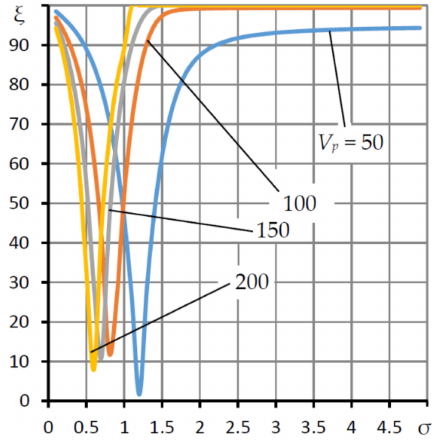
Figure 10. Dependences of the criterion of damping of oscillations for the period ξ on the compression number σ for various values of the dimensionless volume of the inter-throttling chambers and the coefficient of elasticity K e = 2 K e 0